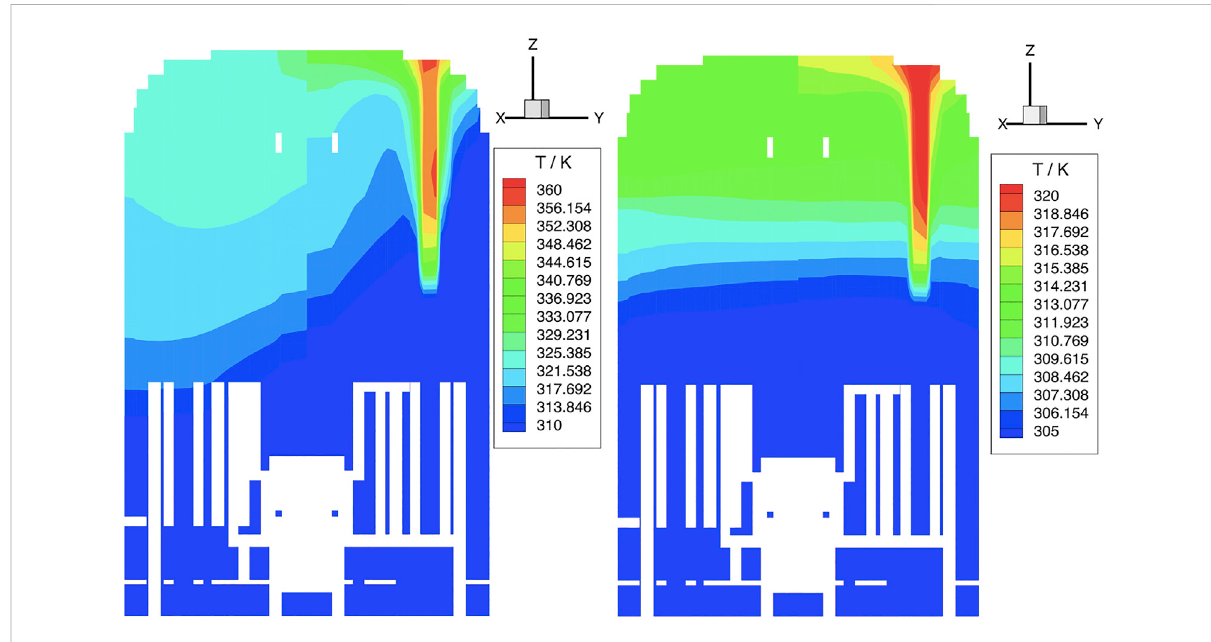
FIGURE 10 Temperature distribution in the longitudinal section of the hydrogen